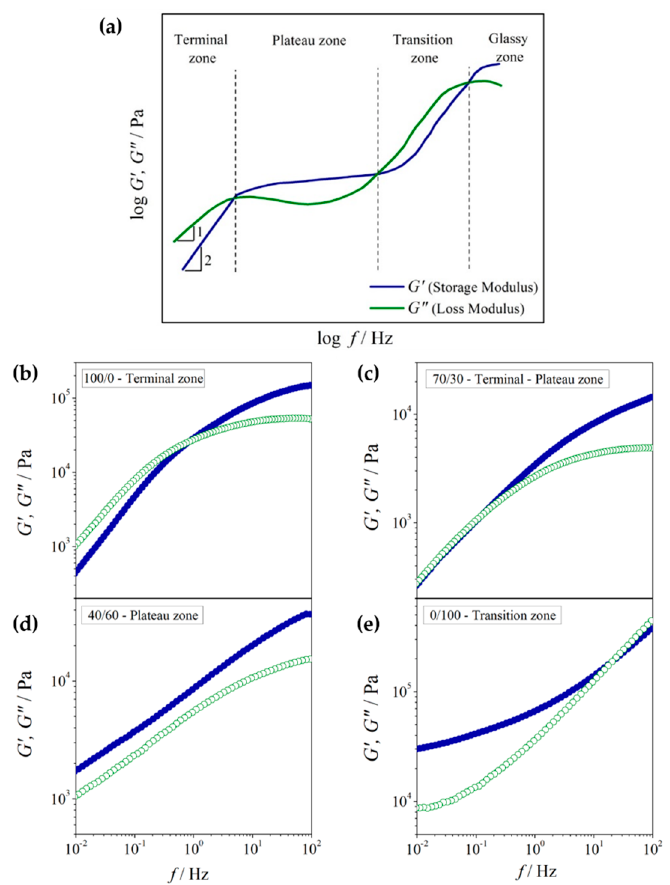
Figure 4. Plots of G' and G" as a function of frequency for ( a ) three-zone model and PEO/NR- g -PMMA blends of ( b ) 100/0 ( c ) 70/30 ( d ) 40/60 and ( e ) 0/100.